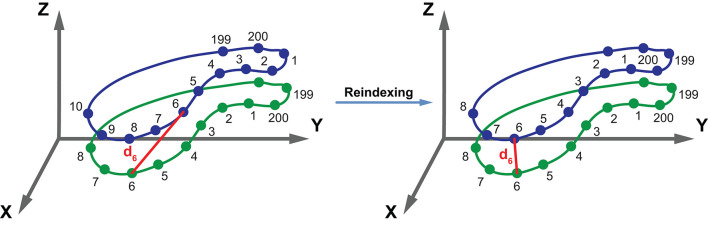
Schematic illustration of the reindexing step. The green and blue contours represent two slices containing equal number (n = 200) of points. The vertices of the blue contour are reindexed in a way that the mean squared error between the corresponding vertices of the green and blue contours becomes minimal. With appropriate reindexing, a vertex with a given index is located approximately at the same anatomical position in both contours. See text for further details. d6, the distance between the points with the index 6 of the two contours.